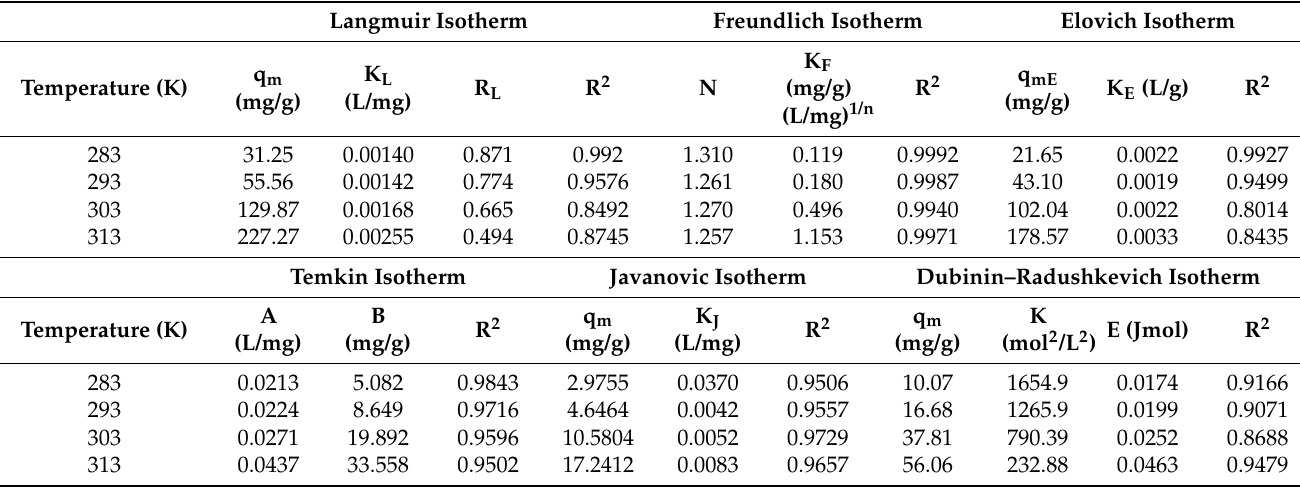
Table 3. Parameter value of the different studied isotherm models obtained in the adsorption of CPC onto AOS. Langmuir Isotherm Freundlich